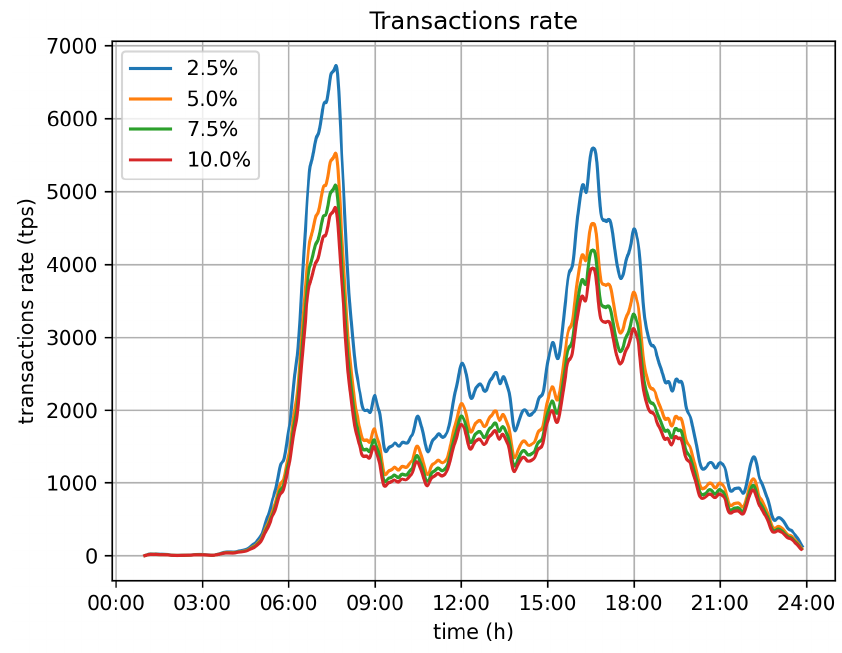
Figure 9. Transaction